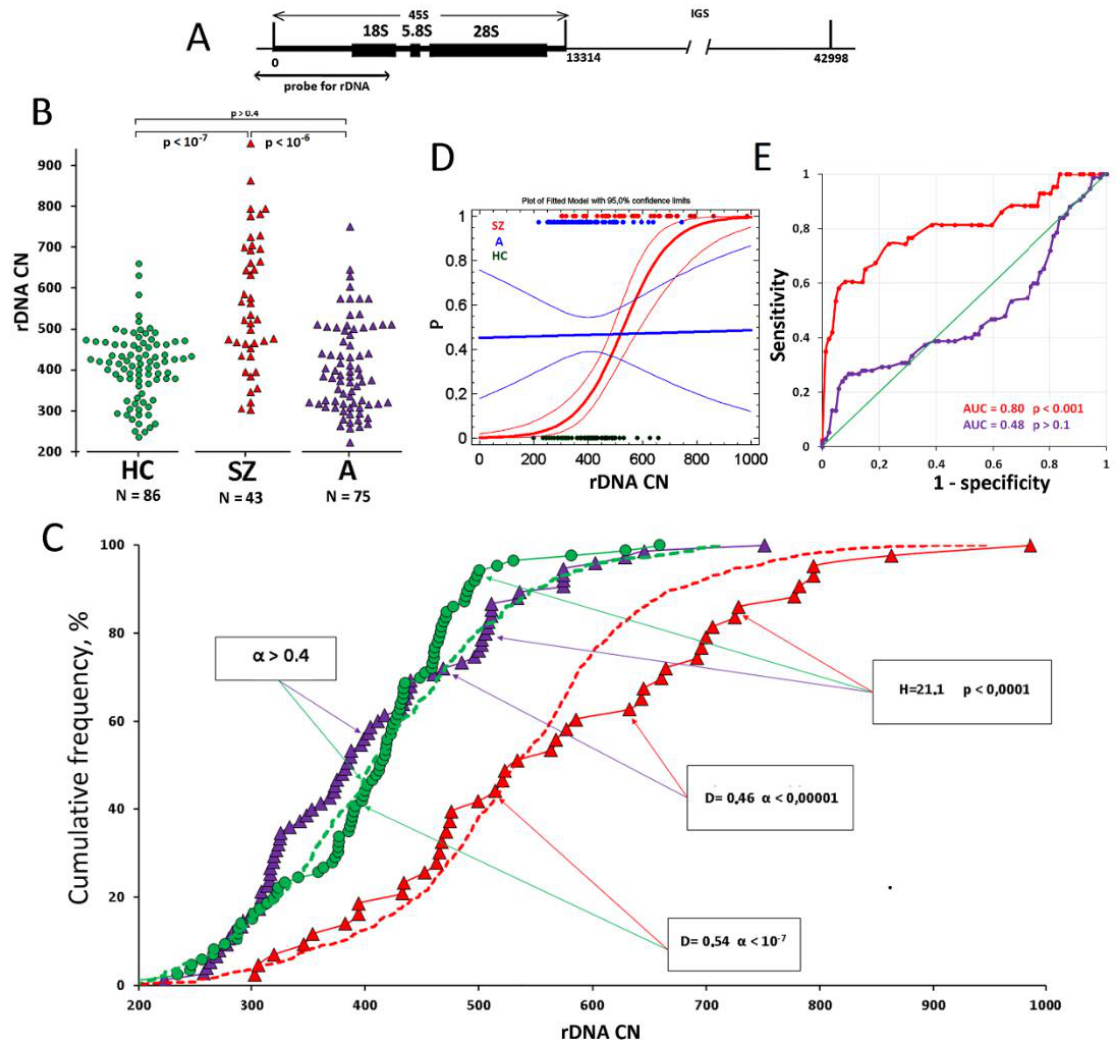
Figure 1. ( A ). Location of genes for rRNA on human chromosomes. Scheme of the ribosomal repeat unit. The area is shown that can be detected using a biotinylated DNA probe for rDNA. ( B ). The values of rDNA abundance obtained in the experiment for the three cohorts of children. ( C ). Comparison of the groups by rDNA CN distribution. The arrows indicate the groups compared, and the frames shows the statistical analysis data. ( D , E ). Logistic curves and ROC curves drawn for the groups of ill children compared to the controls.